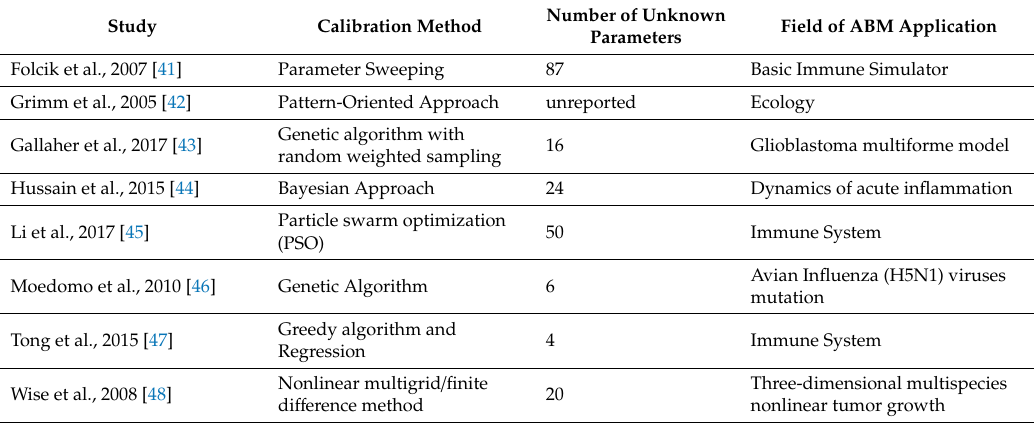
Table 1. Parameter estimation methods in agent-based modeling